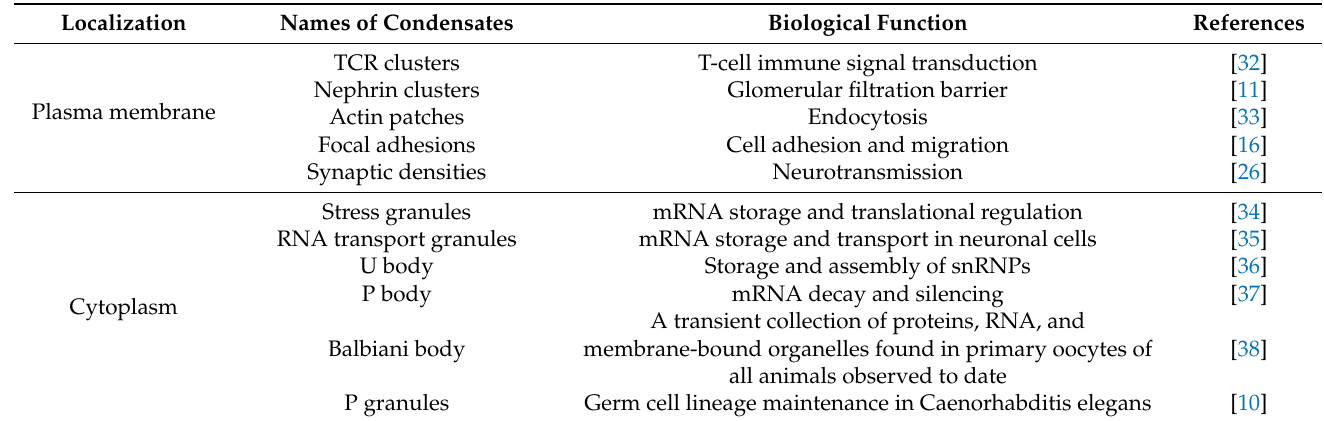
Table 1. Examples of the various MLOs formed by LLPS and their